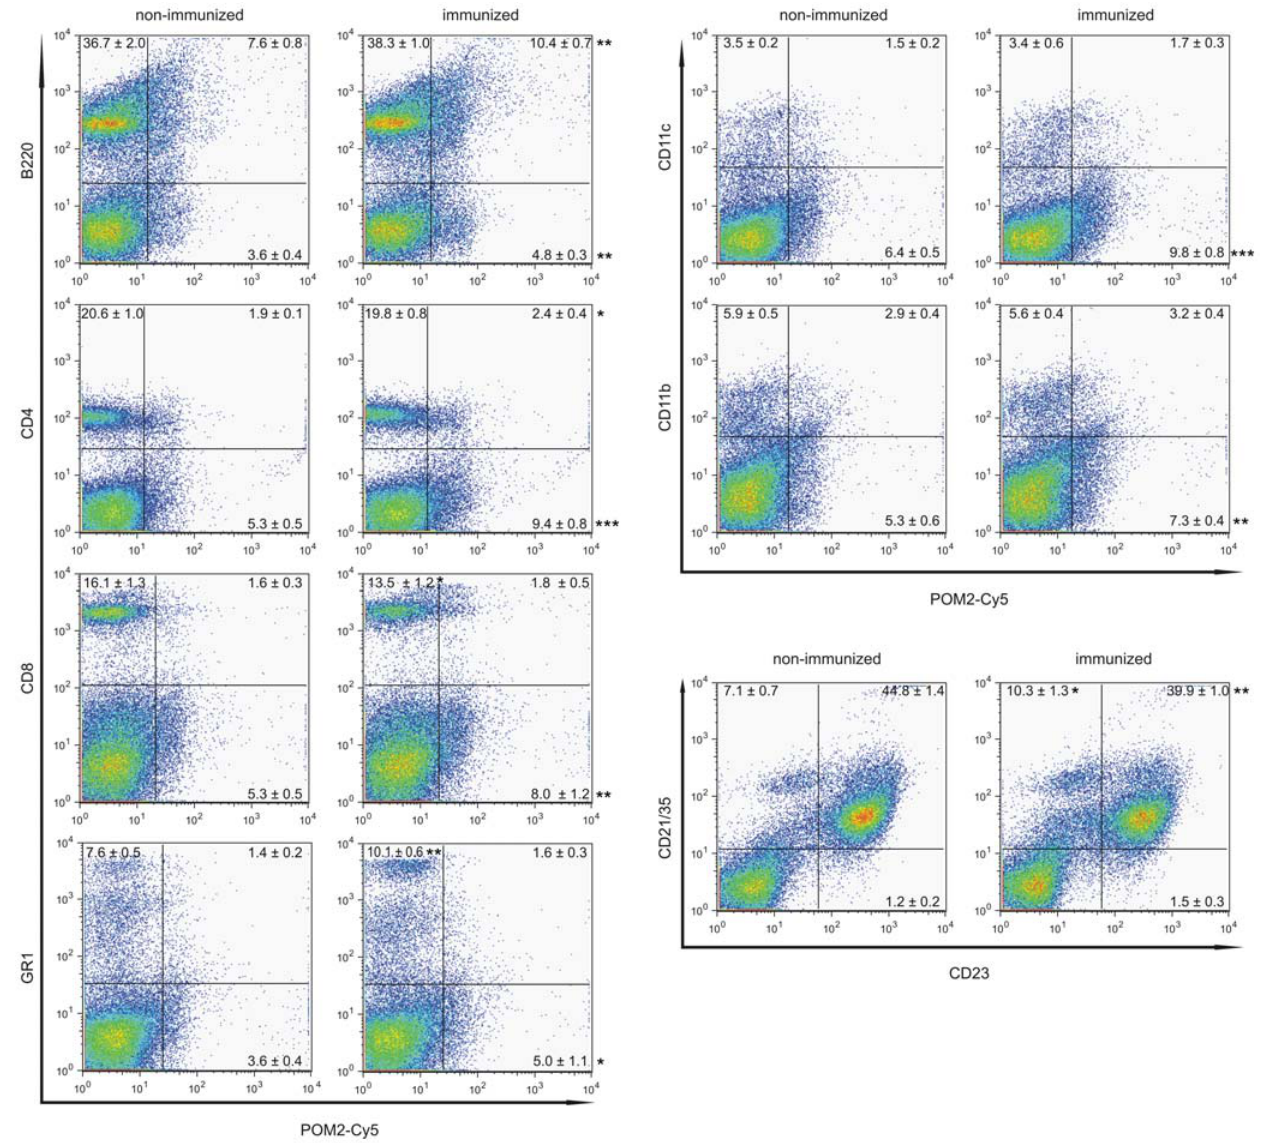
Figure 3. Splenic cell populations in immunized mice. Splenic cells were isolated and co-stained for PrP C and B220, CD4, CD8, GR1, CD11c, or CD11b; alternatively co-staining for CD21/35 and CD23 was performed. Results from representative samples are shown. Four mice per group were analyzed. Numbers in the diagram indicate average percentages of cells 6 standard deviation. Statistical analysis was performed using unpaired t- test, two-tailed. Significantly different percentages are labeled in the right lower scattergram with (*) p , 0.05; (**) p , 0.01; or (***) p ,